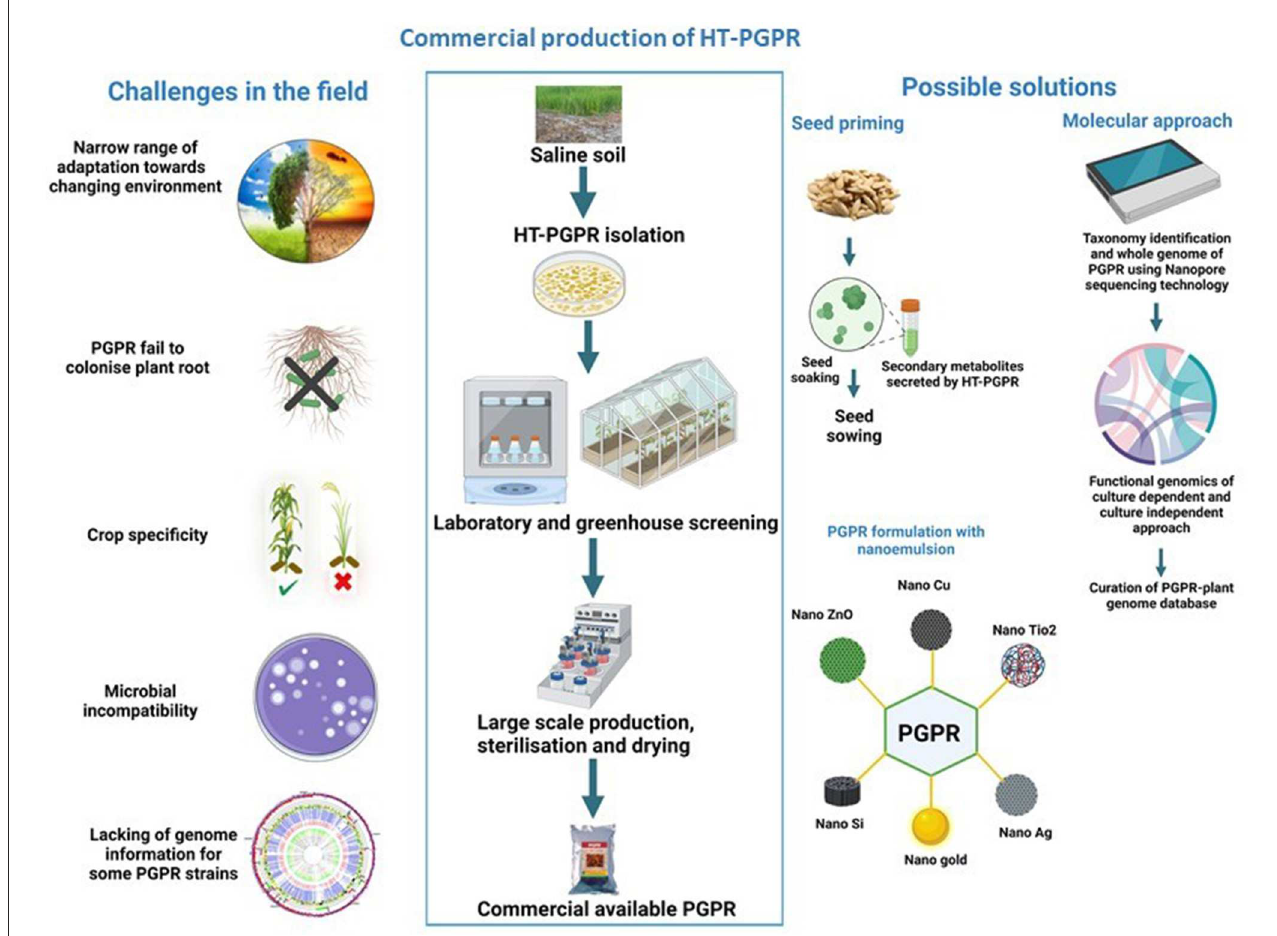
FIGURE2 The major challenges of using halotolerant plant growth-promoting rhizobacteria (HT-PGPR) in the agricultural field and possible solutions to overcome them. The square box represents the steps involved in the commercial production of PGPR under controlled condition, while the (left) and (right) sides of the square explain the various problems involved in employing PGPR in the field and probable solutions to conquer them. Licensed from